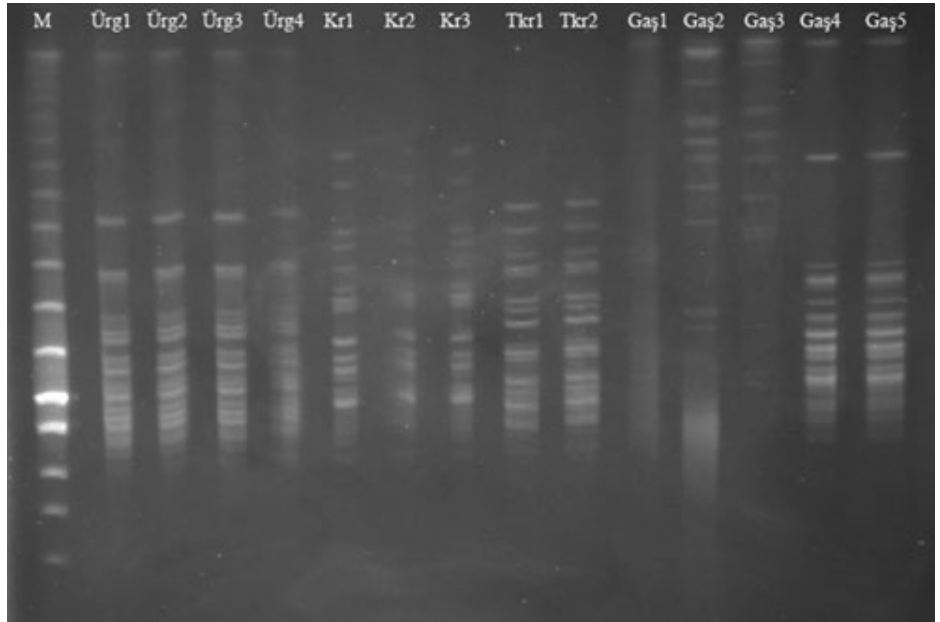
Figure 4. PFGE patterns of chromosomal DNA restriction fragments resolved in 1.6% pulsed field grade agarose for Rhizo- bium vitis DNA digested with Pme I (Marker: NEB Low Range PFGE Marker, Working conditions: 5sec → 45sec, 6V, 14ºC, 20h). The size of the fragments is indicated in